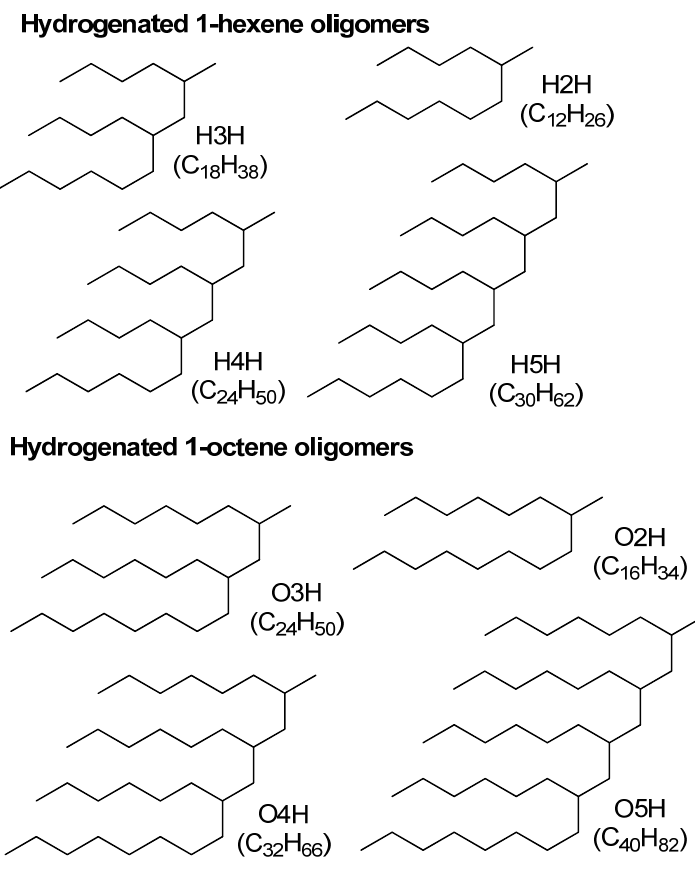
Figure 1. The chemical formulae of the hydrogenated 1-hexene and 1-octene oligomers: dimers (H2H and O2H), trimers (H3H and O3H), tetramers (H4H and O4H), pentamers (H5H and O5H).